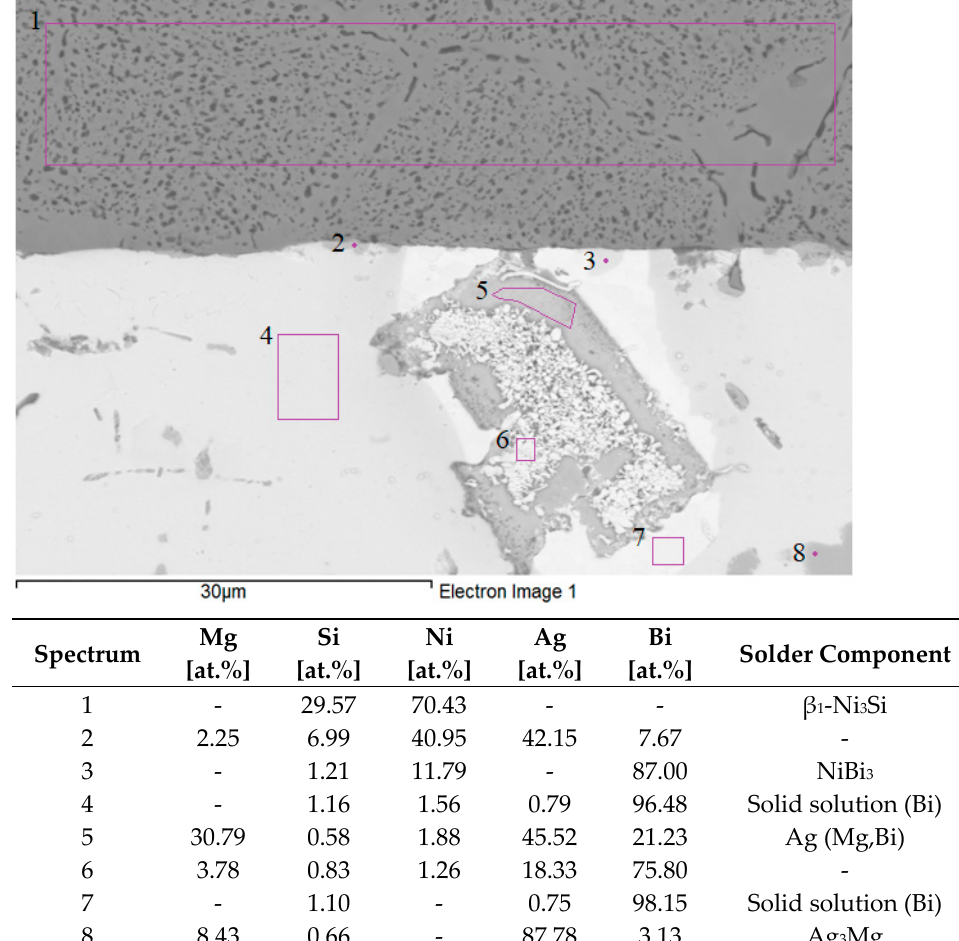
Figure 17. EDX analysis of boundary in Bi11Ag1Mg/Ni–SiC joint.